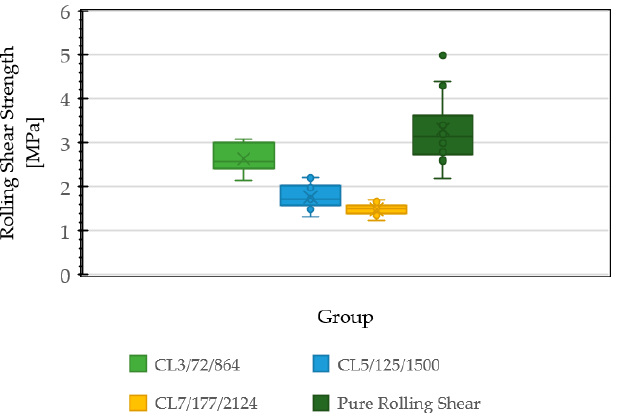
Figure 10. Box plots for CLT rolling shear strength ( f s ) of E. nitens panels with different layups and different finger joint lengths. Results for CL3, CL5 and CL7 panels were obtained through bending tests, whereas pure rolling shear tests were performed only on 3-layer panels.